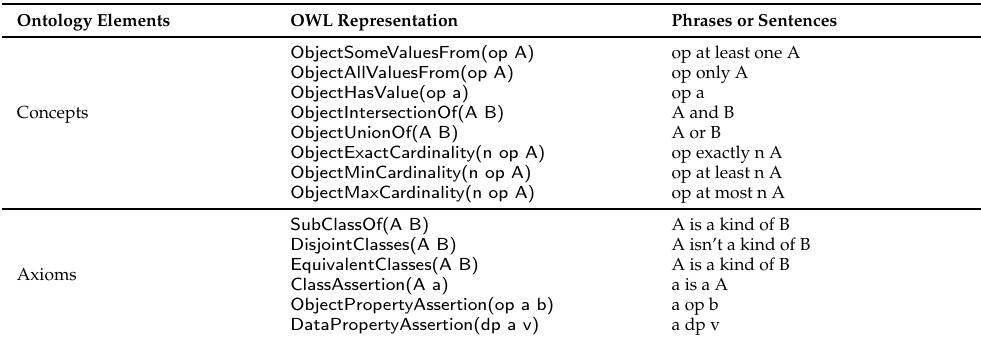
Table 1. Rules to translate OWL concepts or axioms into phrases or sentences, respectively, where a and b are individual names, A and B are concepts, n indicates an integer, op and dp indicate an object property and a data property separately, and v is a